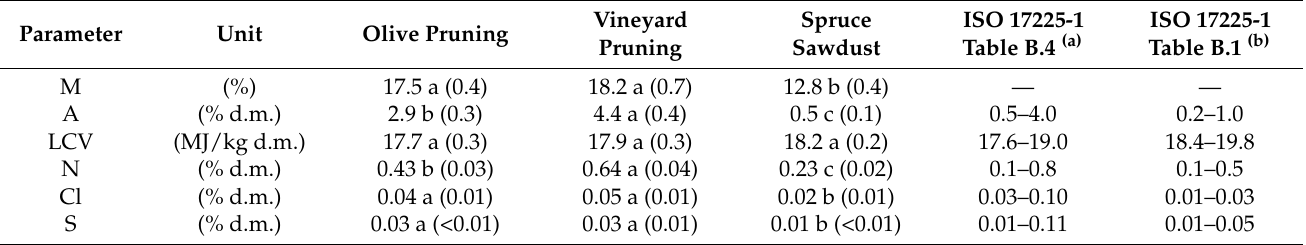
Table 3. Results of analyses carried out on milled biomass materials: olive and vineyard pruning, spruce sawdust (average values with standard deviation in